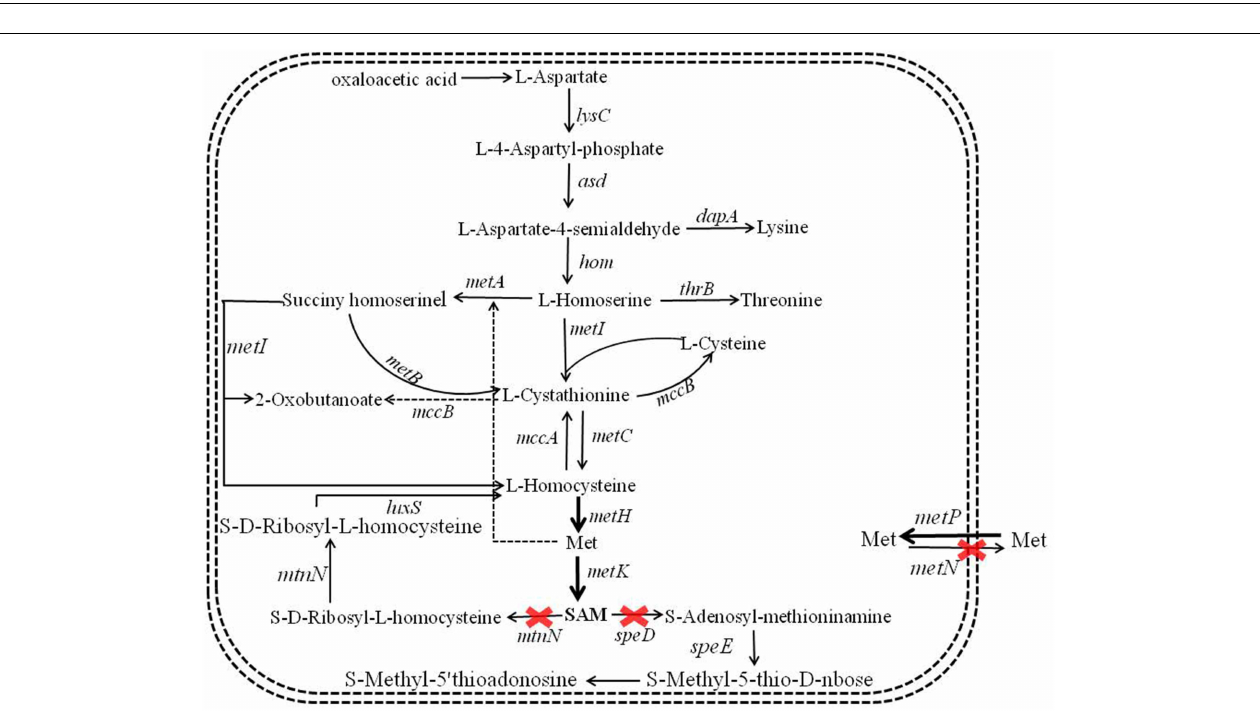
FIGURE 2 | Metabolic engineering of SAM synthetic and degradation, Met transportation pathways for SAM accumulation and bacitracin synthesis in B. licheniformis .